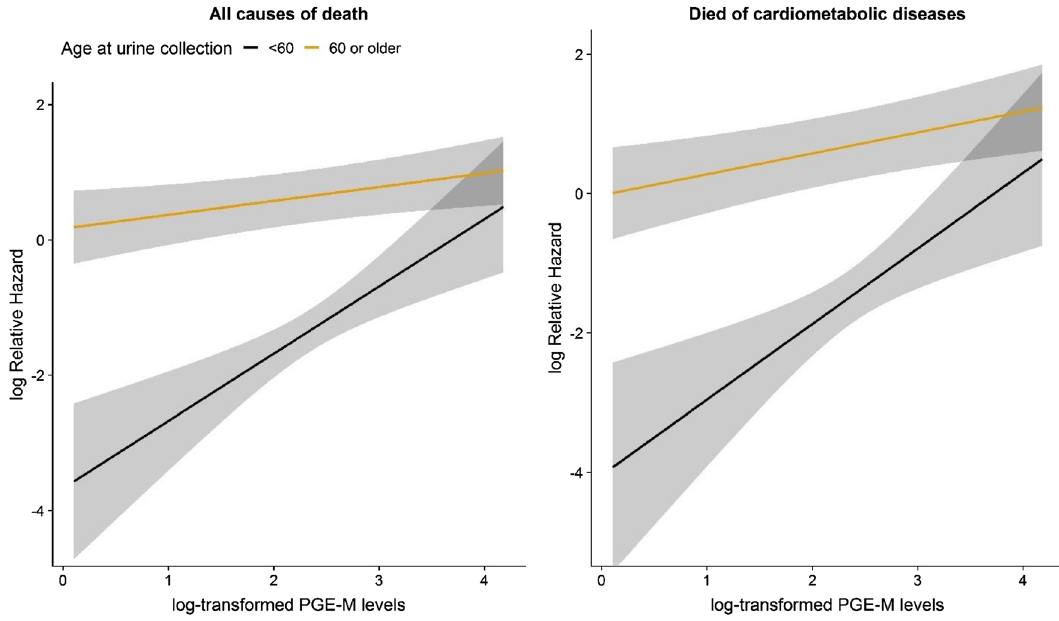
Figure 2. Linear associations of urinary PGE-M levels with all-cause mortality (left) and death from cardiometabolic diseases (right) by age at urine collection (< 60 vs. > = 60 years).